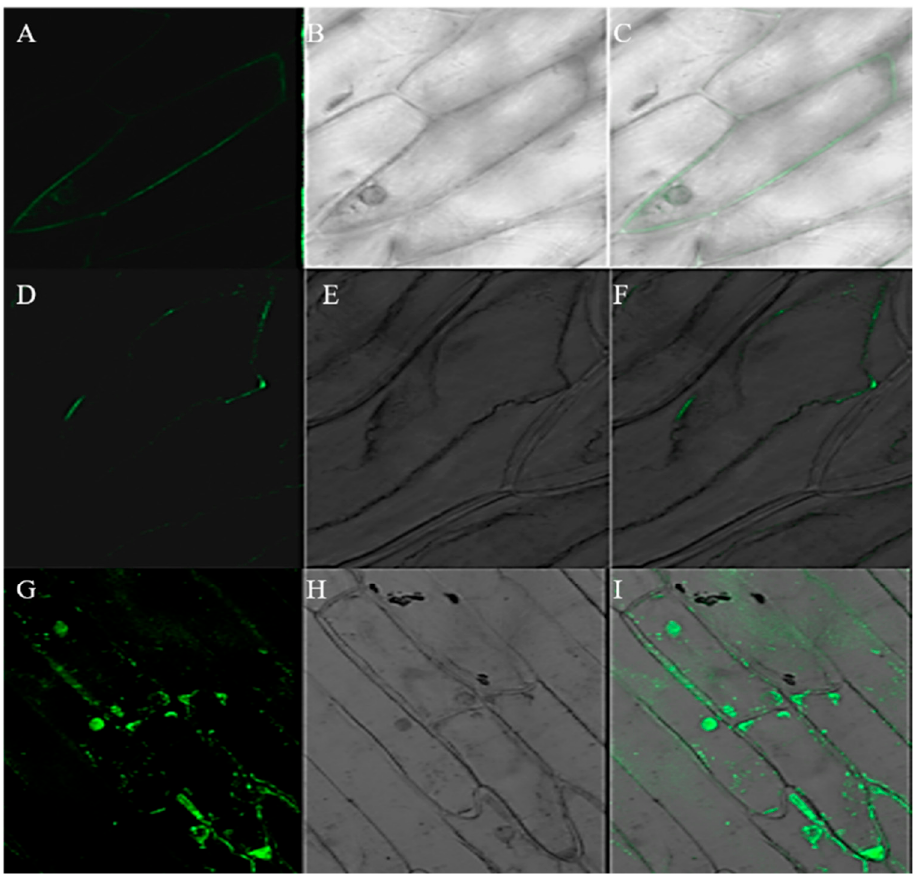
Figure 3. Subcellular localization of the RIN4-GFP protein in onion epidermal cells. ( A – C ): before plasmolysis; ( D – F ): post plasmolysis; ( G – I ): pBEGFP control vector; ( A , D , G ): fluorescent field;